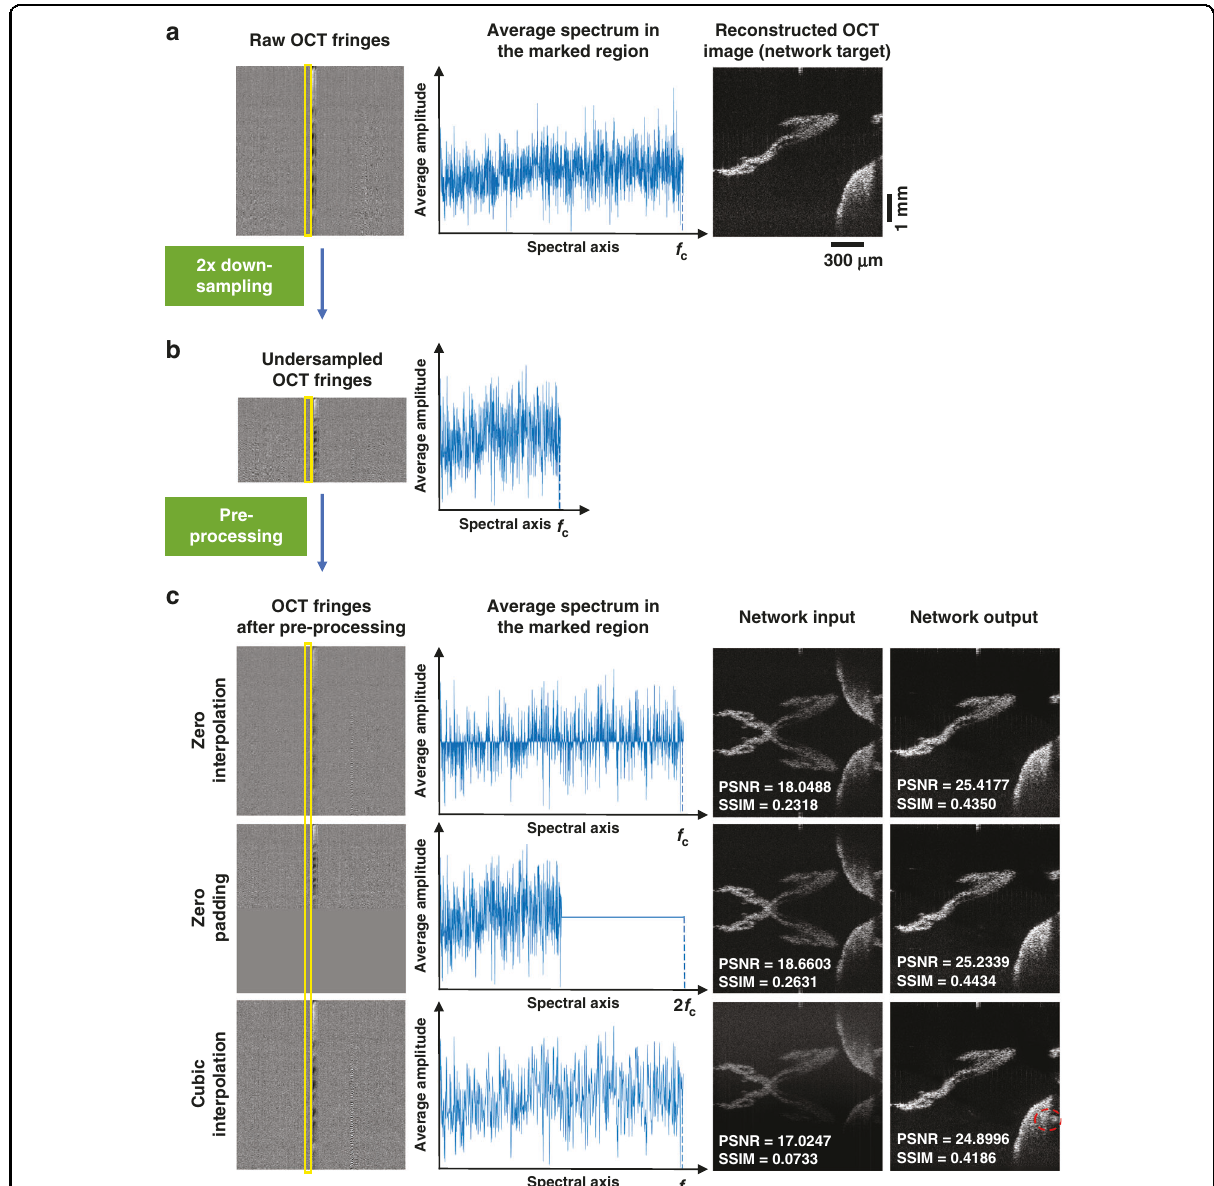
Fig. 4 Comparison of different pre-processing methods for DL-OCT. a Raw SS-OCT spectral fringes and the corresponding reconstructed OCT image (ground truth), where f c indicates the cut-off frequency of the spectral data. b 2-fold undersampled OCT fringes. c Undersampled OCT fringes that are pre-processed using different interpolation methods. Three separate neural networks were trained for each one of the pre-processing methods to generate the network outputs. PSNR and SSIM values are also displayed for each one of these fi